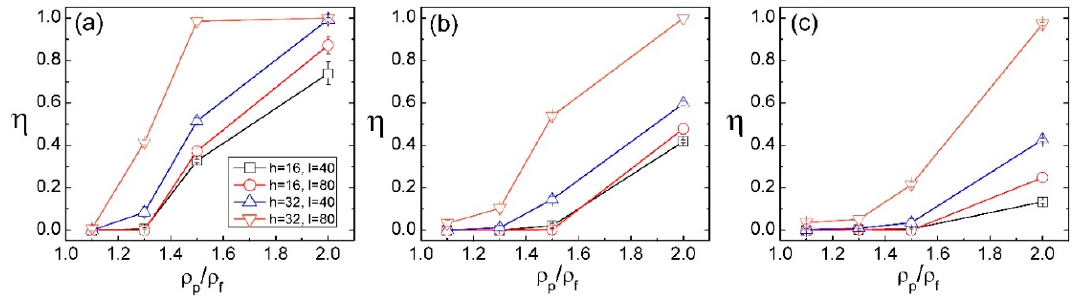
Figure 26. The trap efficiency as a function of particle density for different Reynolds numbers: ( a ) Re = 28.44, ( b ) Re = 56.88, ( c ) Re = 85.32.